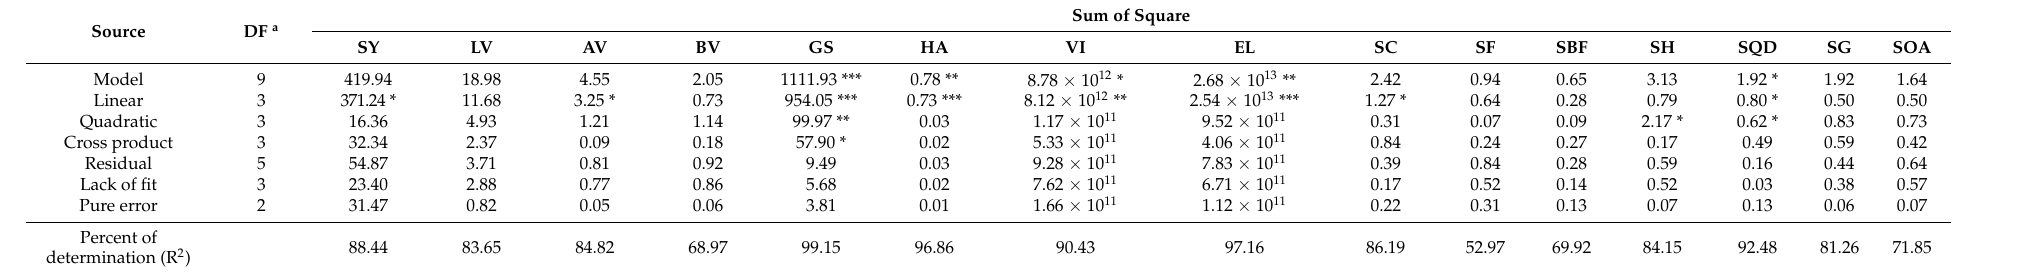
Table 4. Analysis of variance for response variables based on various responses.